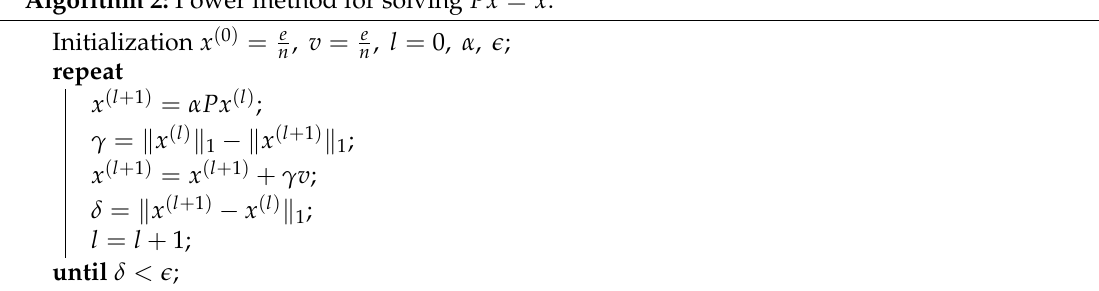
Algorithm 2: Power method for solving ¯ Px = x